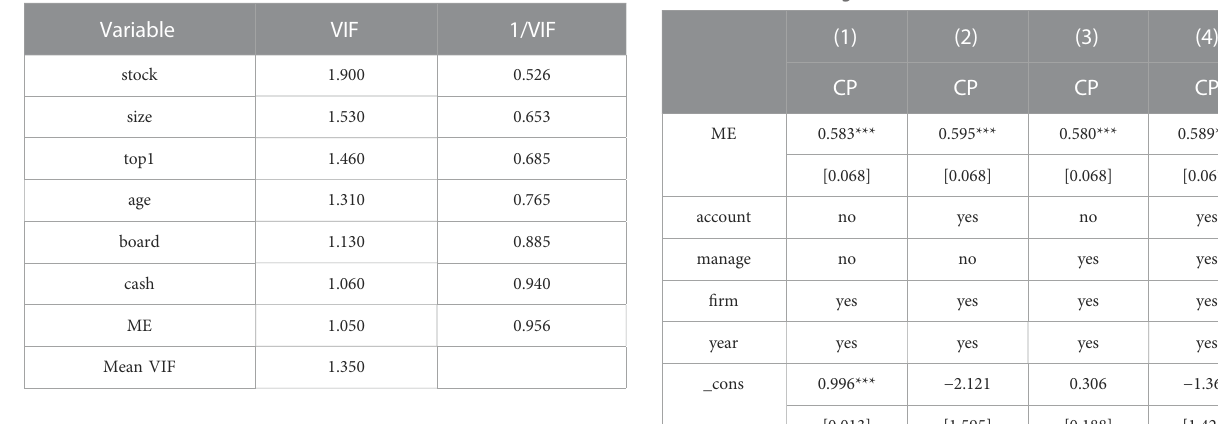
TABLE 4 Variance in fl ation factor. TABLE 5 Benchmark